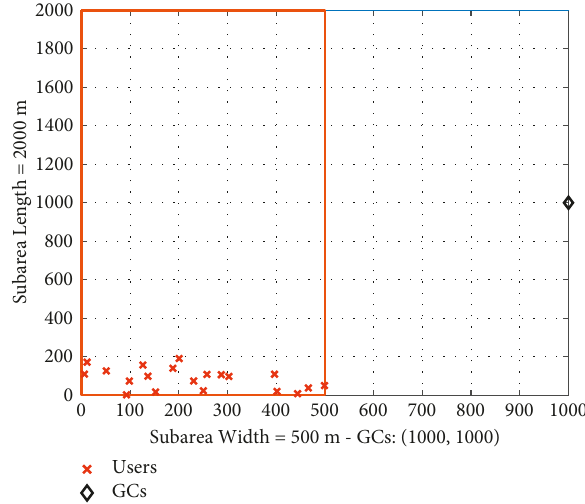
Figure 2: System settings of a coverage